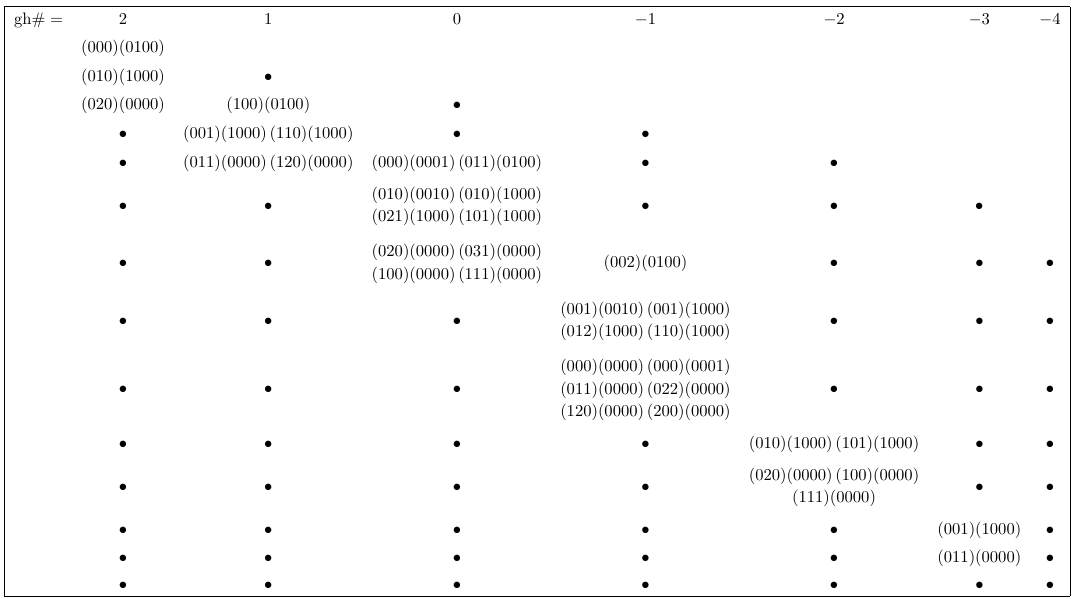
Table 1 . The zero-mode cohomology in Ψ . The superfields at different ghost numbers are shifted so that fields in the same row has the same dimension. Black dots denote the absence of